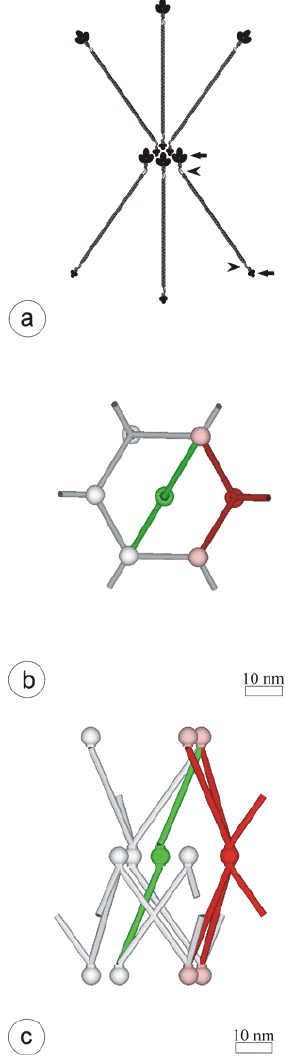
FIGURE 8. (a) Basic unit of the collagen arrangement in the hexagonal phase of dogfish egg case collagen. The heads of three collagen molecules join with the tails of three other molecules (arrows). Likely interruptions of the triple helices (chevrons) may endow the molecules with the necessary flexibility to form networks. (b) Transverse view and (c) longitudinal view of the molecular arrangement proposed in the hexagonal columnar phase. One basic unit is highlighted in red. Occasionally, molecules can aggregate differently (green molecules) and give rise to the protein density seen in the middle of the